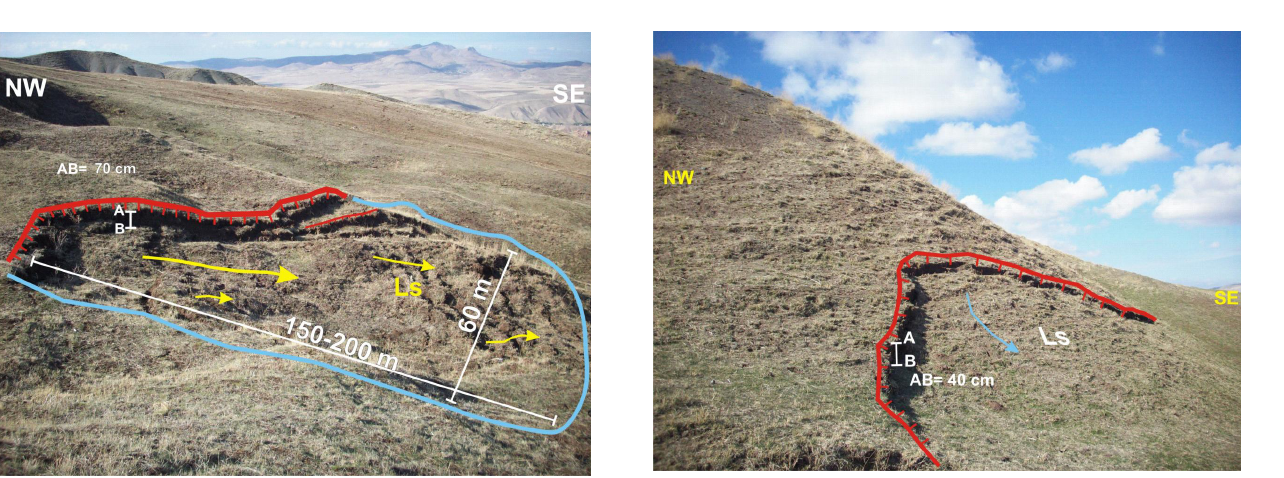
Figure 5. A view from a landslide on a slope located west of Lake Erçek. 3 Fig. 5. A view from a landslide on a slope located west of Lake Erc¸ek.